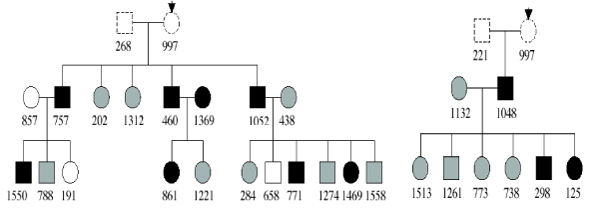
COGA pedigree 10022. The 11 individuals with black shading were considered to be affected, the unshaded individuals in the last 2 generations (857, 191, and 658) were considered unaffected, and the gray individuals were treated as unknown. There was no available information about the phenotypes or genotypes of the 3 distinct founders in the first generation (268, 997, and 221). Note: The 2 circles in the first generation that are marked with an arrow represent a single individual.